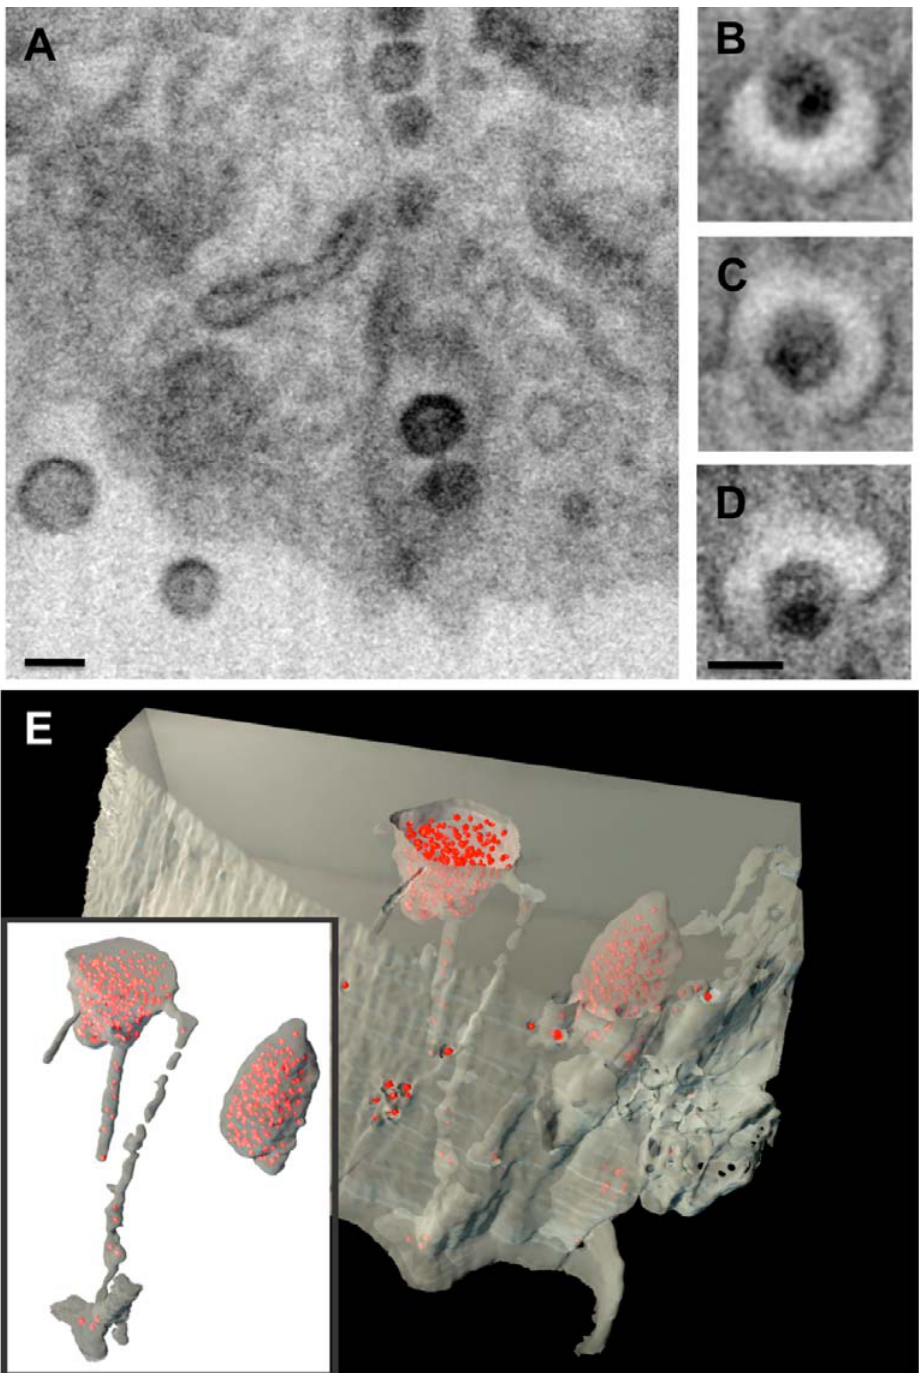
Figure 1. Assembly of HIV-1 in an internal compartment in primary monocyte-derived macrophages (MDMs). Ion-abrasion scanning EM shows the internal virus-containing compartments in MDMs and the virion channels connecting these compartments with the cell surface. (A) Transverse and (B-D) axial sections are shown, with scale bars = 100nm. (E) Reconstruction of a 3D image from IA-SEM, showing internal HIV-1 particles (red) and virion channels. Reprinted from Bennett et al. (2009)